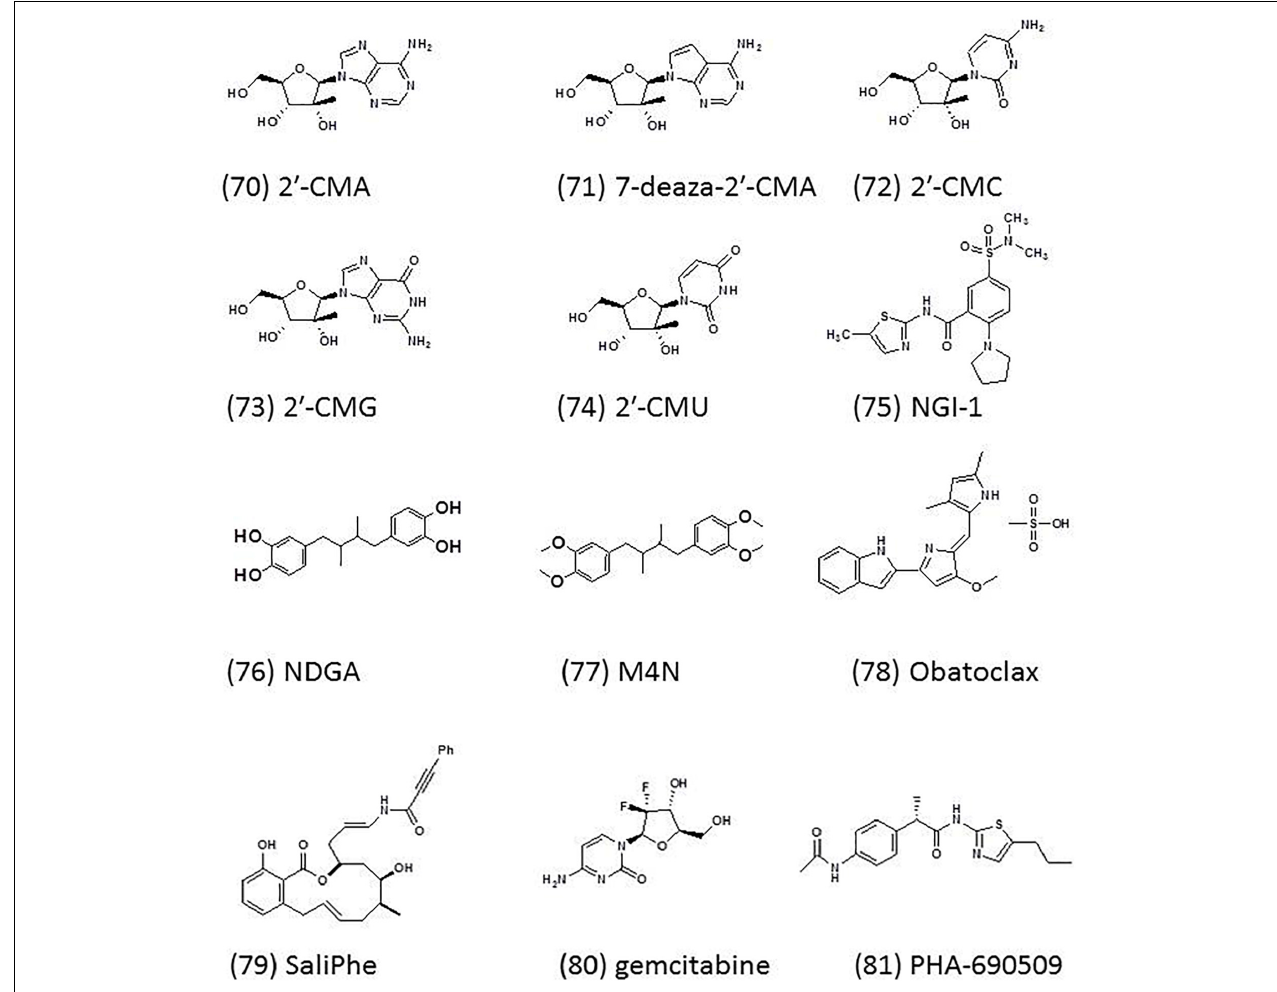
FIGURE 3 | Chemical structures of ZIKV small-molecule